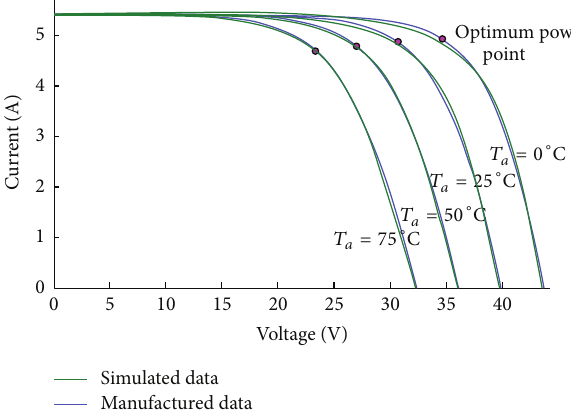
Figure 5: I-V characteristic curves at various temperatures.